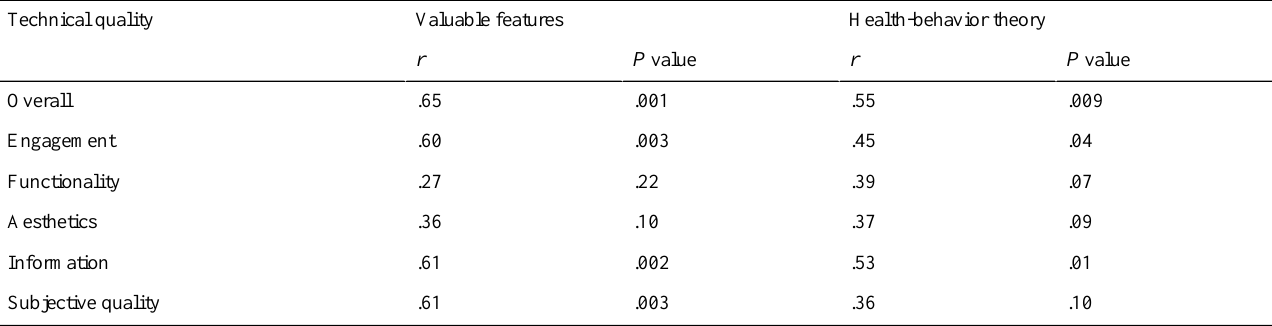
Table 2. Correlations a between mean scores of technical quality with mean scores of valuable features and health-behavior theory for evaluated dialysis diet apps